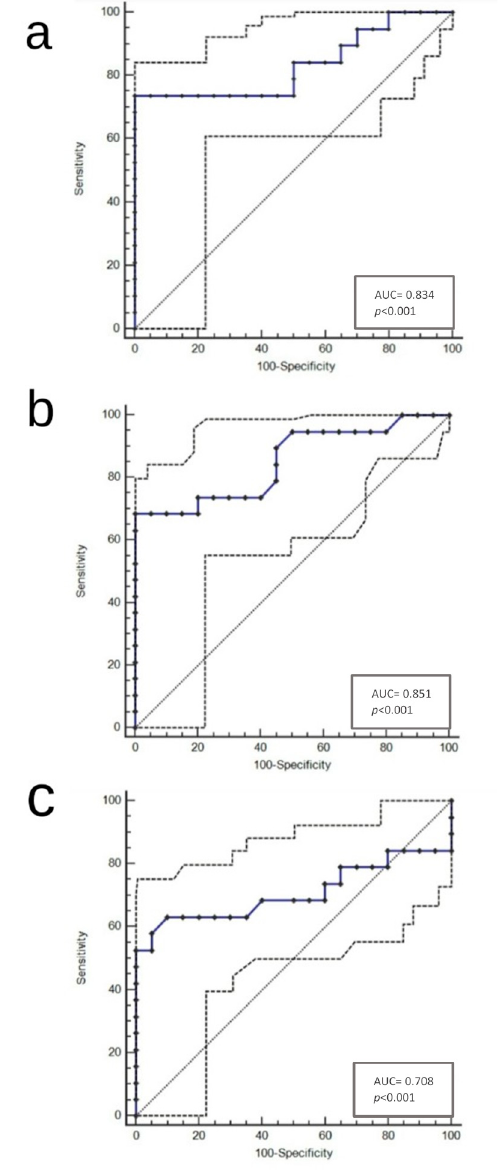
Figure 1. ( a – c ): ROC curves for BTA/TV (cut-off > 0.05) ( a ), BTV/TV (cut-off ≥ 0.0034) ( b ) and BTV/BTA (cut-off ≥ 0.086) ( c ). Abbreviations: ROC, Receiver Operating Table 2. Correlation among ratios between bioptic and surgical tumor volumes and GS (Gleason Score) agreement.